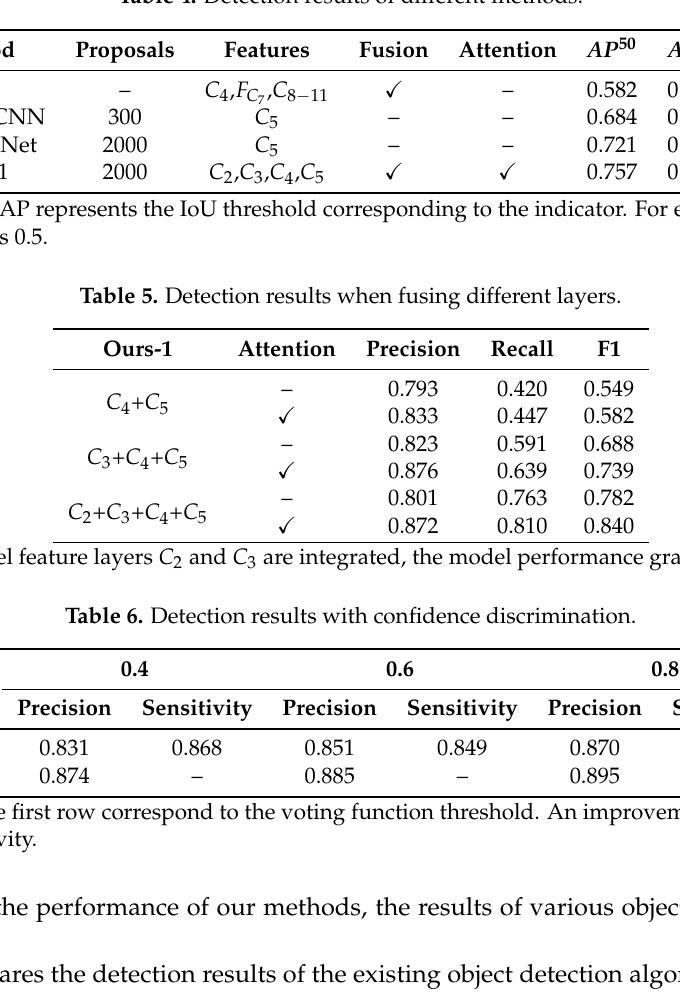
Table 4. Detection results of different methods.